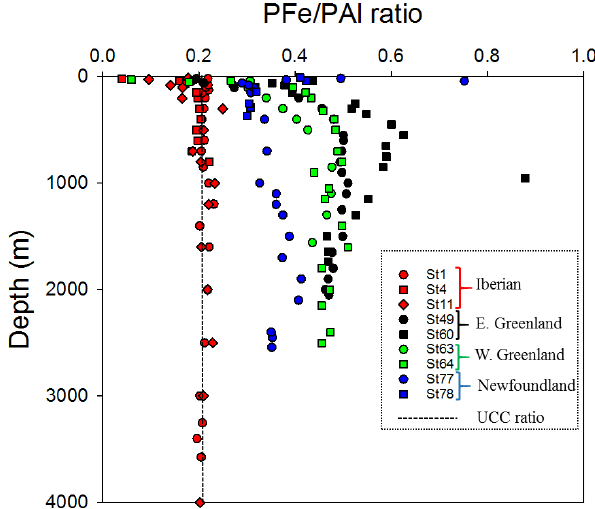
Figure 9. Scatter of the PFe / PAl ratio at the Iberian (red dots), East Greenland (black dots), West Greenland (green dots), and Newfoundland margins (blue dots). Dashed line indicates the UCC PFe / PAl ratio (Taylor and McLennan,